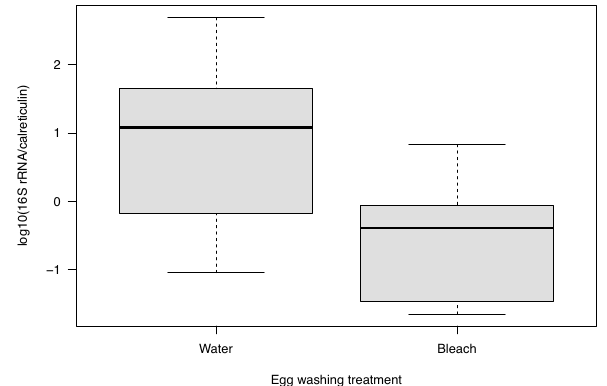
Figure 2. The egg surface sterilization treatment reduced the bacterial microbiota of the I. ricinus larvae. The labels ‘Water’ and ‘Bleach’ (on the X-axis) refer to the control and surface sterilization treatments that were applied to the eggs that had been laid by the 10 engorged adult female I. ricinus ticks. For each of the 20 batches of larvae (10 tick families × 2 egg surface treatments), we froze subsets of ~ 200 larvae at 6 weeks after hatching and extracted the DNA in pools of ~ 100 larvae (total of 40 pools). We used qPCR to determine the ratio of the bacterial 16S rRNA gene copy number to the tick calreticulin gene copy number, which measures the abundance of the tick-associated bacterial microbiota. This ratio was 28 times higher for the control larvae that hatched from the control eggs (‘Water’ treatment) compared to the dysbiosed larvae that hatched from the surface- sterilized eggs (‘Bleach’ treatment), and this difference was highly significant (p = 0.0000005). The ratios of the bacterial 16S rRNA to tick calreticulin gene copy numbers were log10-transformed to improve normality and the appearance of the graph. The boxplots show the median (black line), 25th and 75th percentiles (edges of the box), and minimum and maximum values (whiskers).